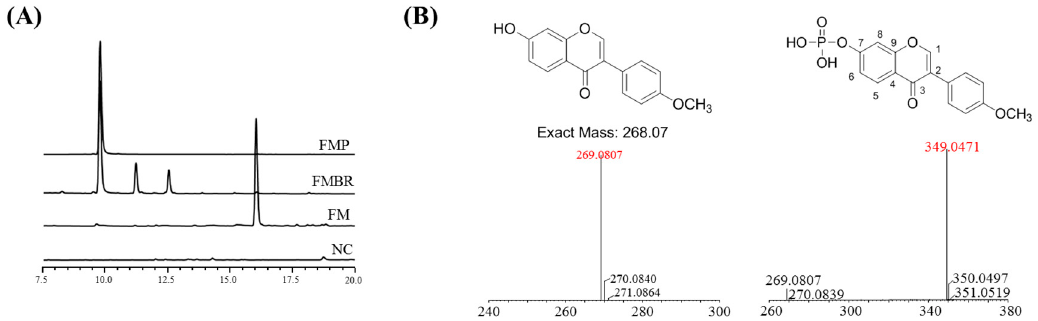
Figure 1. ( A ) HPLC analysis of formononetin (FM), a formononetin biorenovation product (FMBR), a biorenovation negative control (NC), and formononetin 7- O -phosphate (FMP); ( B ) structure and mass analysis of FM and FMP.